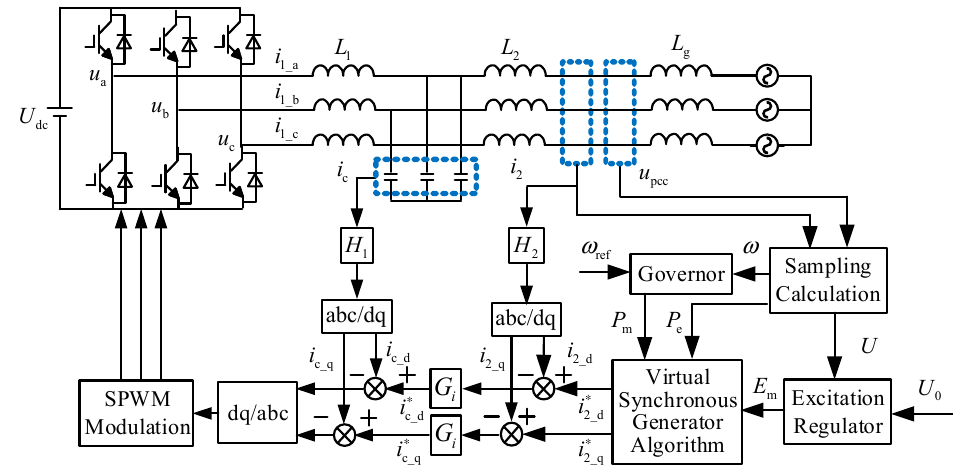
Figure 1. Control circuit diagram of current-controlled virtual synchronizer system.